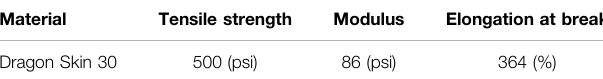
TABLE 2 | Material properties of silicone actuator